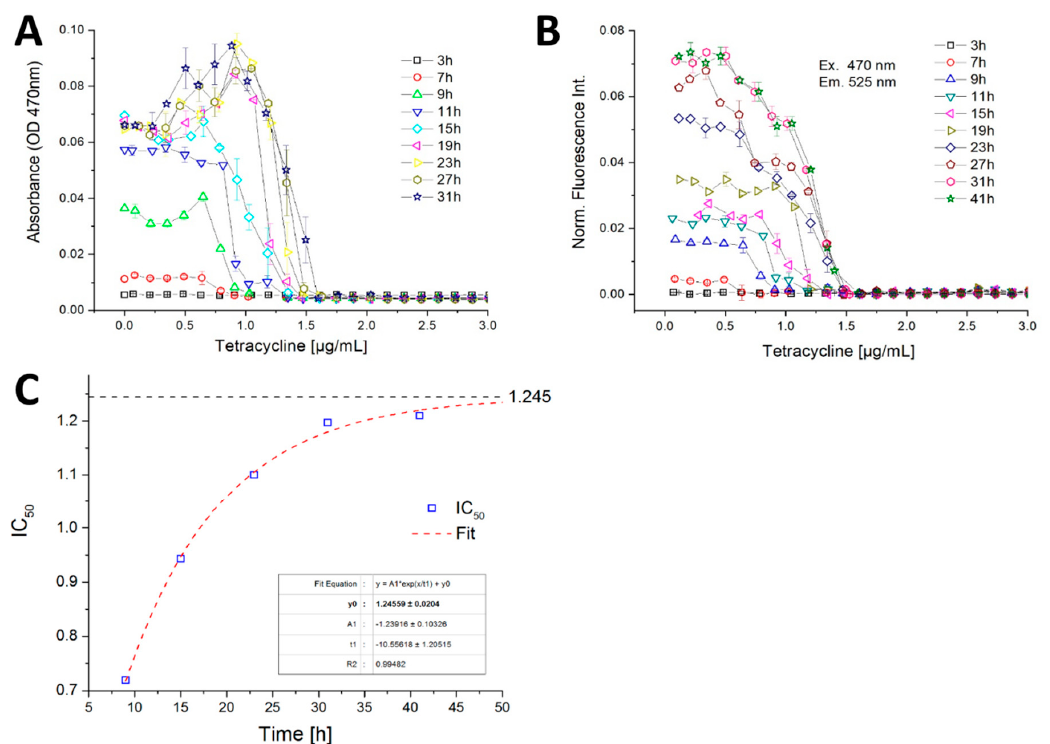
Figure 11. Dose–response curves with high concentration- and temporal-resolution based on the ( A ) optical density and ( B ) autofluorescence intensity of B. megaterium against tetracycline obtained in micro-fluid segment sequences with continuously varied effector concentrations; ( C ) IC50 value development during the incubation time from 7 to 41 h. Asymptotic fit reveals an IC50 value of about 1.245 µg/mL.